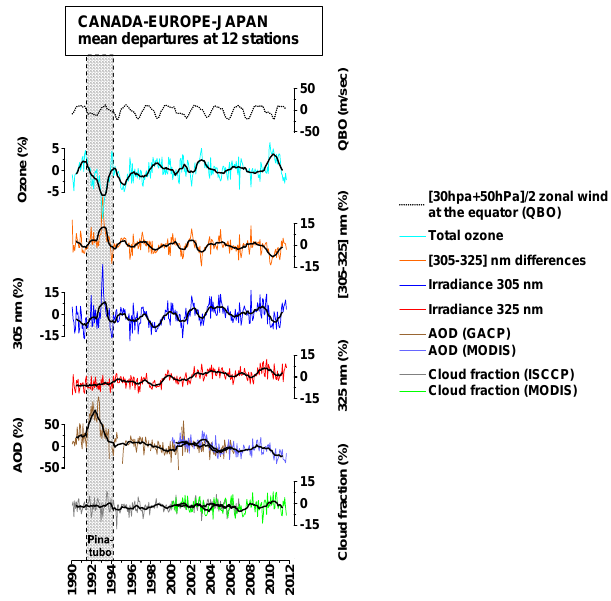
Fig. 1. Changes in (%) in total ozone, UV irradiances at 305 and 325nm, AOD at 550nm and cloud fraction averaged over 12 sta- tions located between 25 ◦ N and 60 ◦ N. The third time series shows the long-term variability of the difference (in %) between 305nm and 325nm solar spectral irradiance. Solid black curves are 12- month running